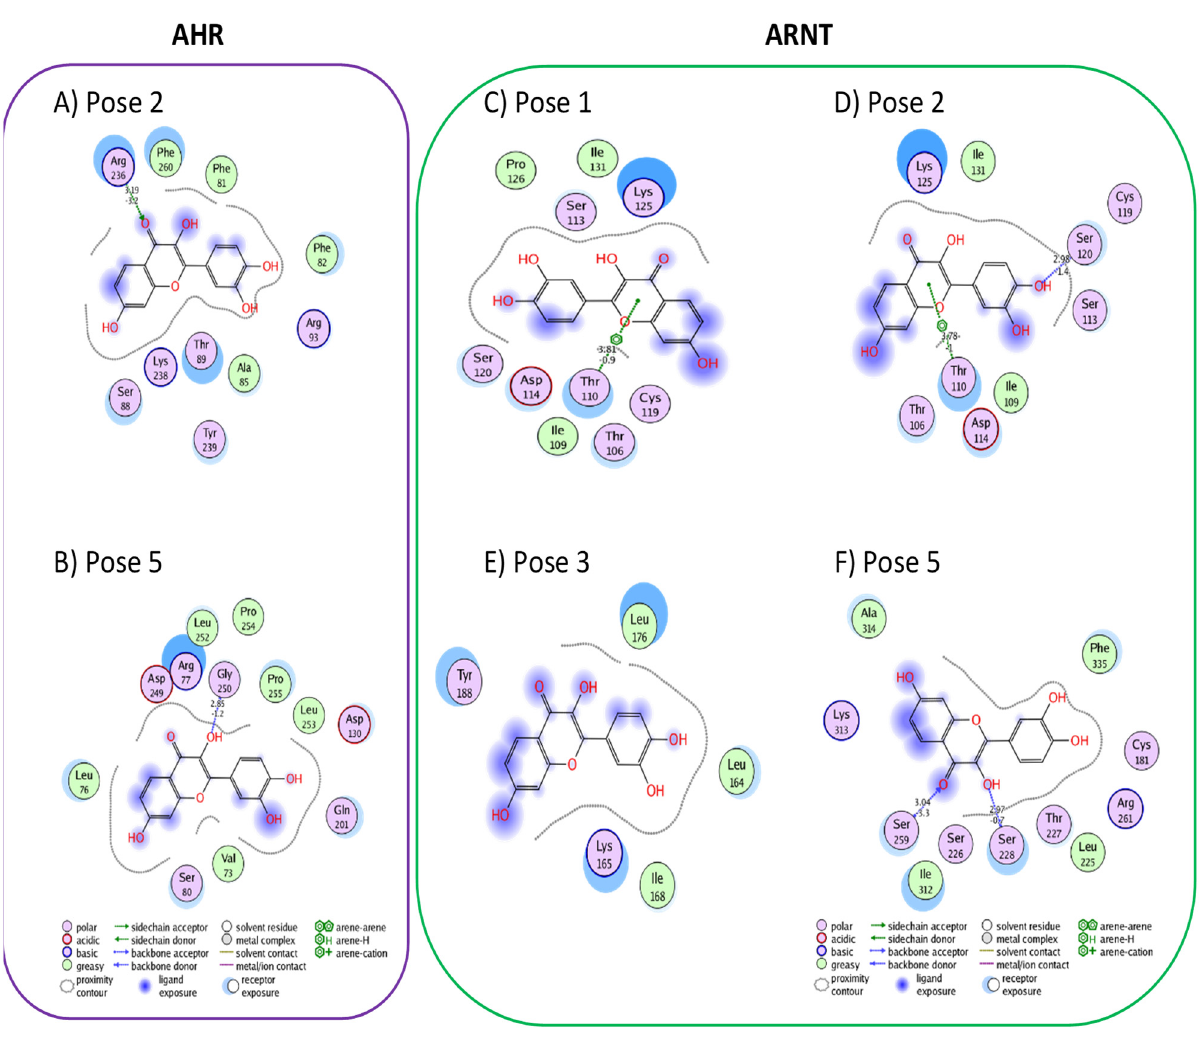
Figure 7. Interaction network between monomeric proteins AHR, ARNT and the studied compound 2 .